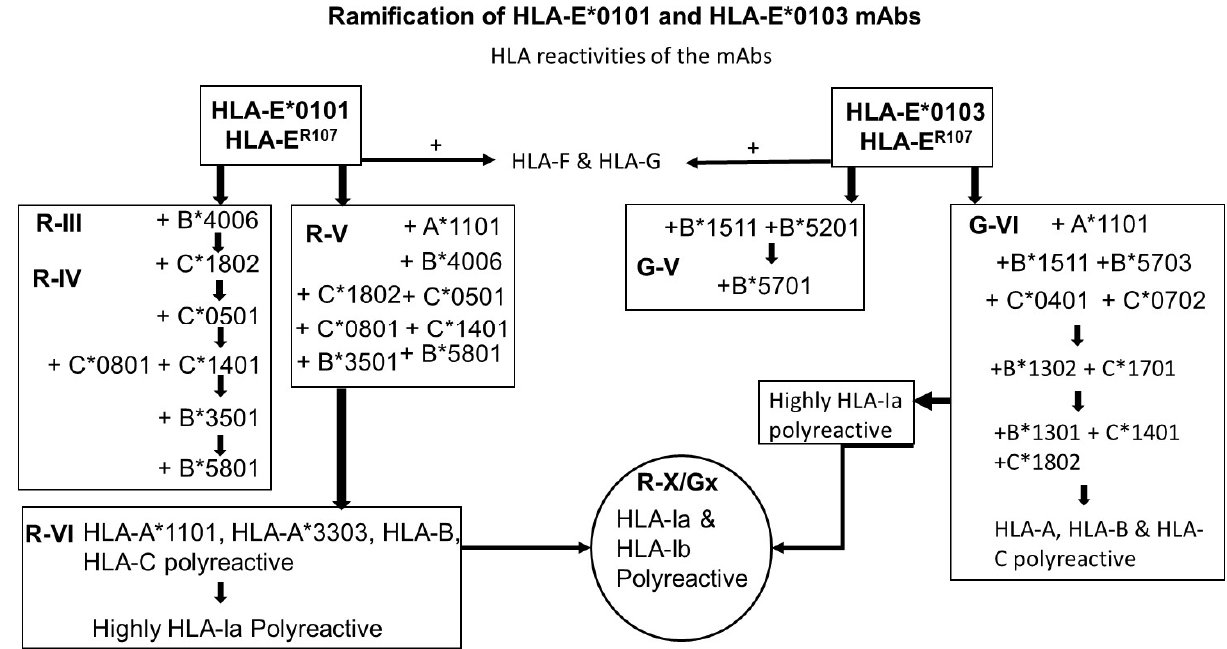
Figure 7. Diagrammatic illustration of the ramification of HLA-I reactivity of the anti-HLA-E*0101 and anti-HLA-E*0103 mAbs.